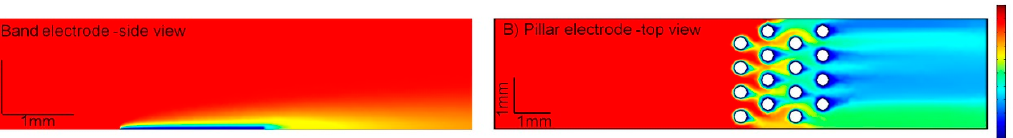
Figure 1. Concentration profiles of the analyte (mol L − 1 ) in a simplified electrochemical reaction in a microfluidic channel calculated using COMSOL. ( A ) using a microband electrode (side view) and ( B ) using 16 vertical posts as electrodes (top view). The channel dimensions, flow rates ( V f ) and over-potential are the same in both systems. Red color denotes high concentration and blue color low concentration. In (A) the collection efficiency is a mere 3% compared to 81.5% in (B). Pencil graphite electrodes are also rarely applied in microfluidic systems. Pencils